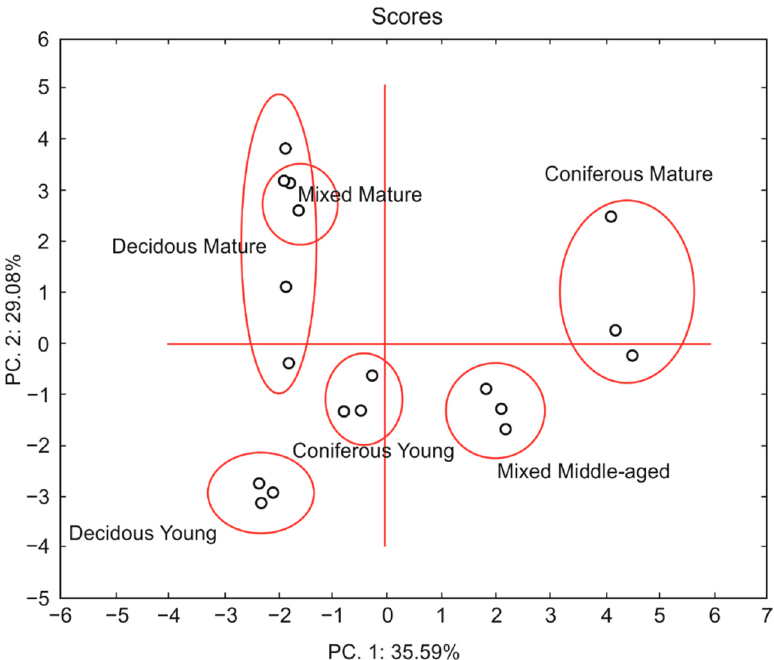
Figure 9. PCA plot of the properties of soils from mature and young coniferous, deciduous, and mixed forests.